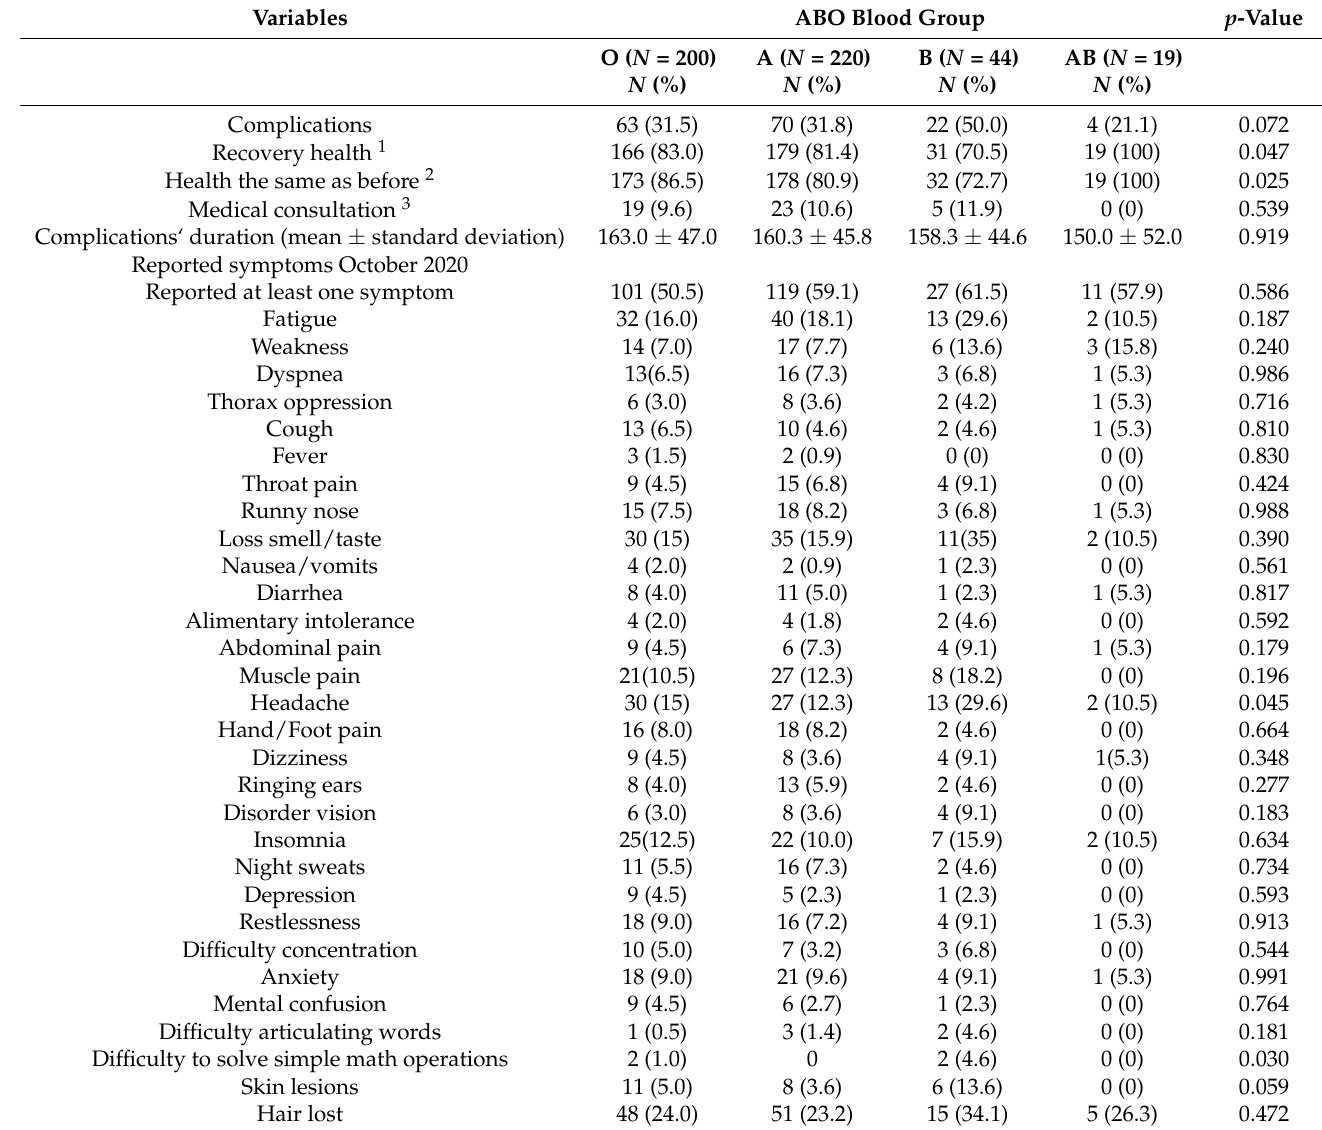
Table 4. Complications and now reported symptoms post-COVID-19 and ABO blood group. Borriana COVID-19 cohort 2020.